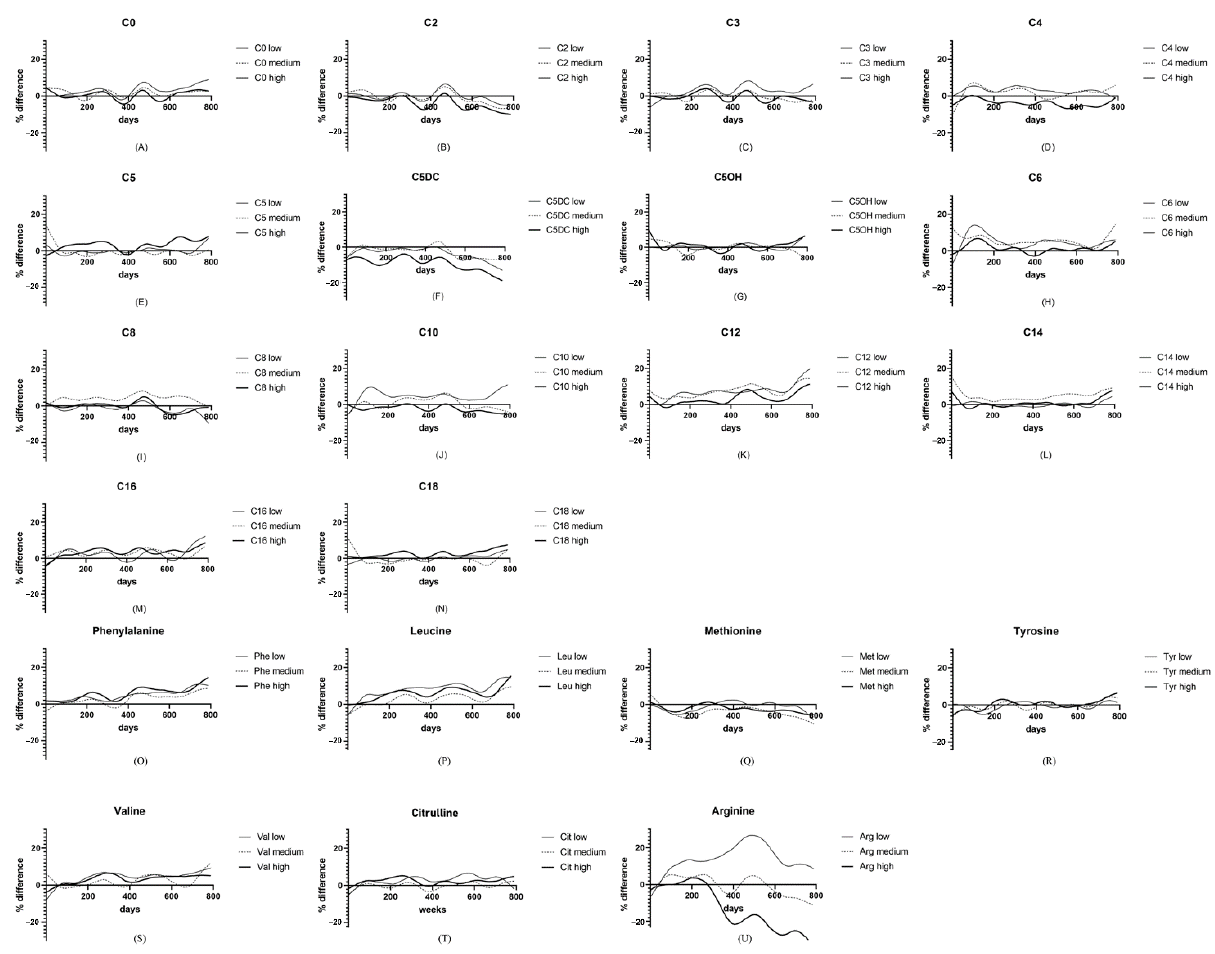
Figure 2. Nomogram for the percent difference between measured value and the initial mean between D0 and D788. Smooth curves derived from the percent difference between consecutive measured values and initial means of each analytes. According for level of NSQAP QC materials, thin solid lines, spotted lines, and bold sold lines represented low, medium, and high level, respectively. Amino acid; low: Lot 221; medium: Lot 222; high: Lot 223 of NSQAP QC materials; Acylcarnitine; low: Lot 262; medium: Lot 263; high: Lot 264 of NSQAP QC materials; C0: free carnitine ( A ); C2: acetylcarnitine ( B ); C3: propionylcarnitine ( C ); C4: butyrylcarnitine ( D ); C5: isovalerylcarnitine ( E ); C5DC: glutarylcarnitine ( F ); C5OH: hydroxyisovalerylcarnitine ( G ); C6: hexanoylcarnitine ( H ); C8: octanoylcarnitine ( I ); C10: decanoylcarnitine ( J ); C12: dodecanolycarnitine ( K ); C14: myristoylcarnitine ( L ); C16: palmitoylcarnitine ( M ); C18: stearoylcarnitine ( N ); Phe: phenylalanine ( O ); Leu: leucine ( P ); Met: methionine ( Q ); Tyr: tyrosine ( R ); Val: valine ( S ); Cit: citrulline ( T ); Arg: arginine ( U